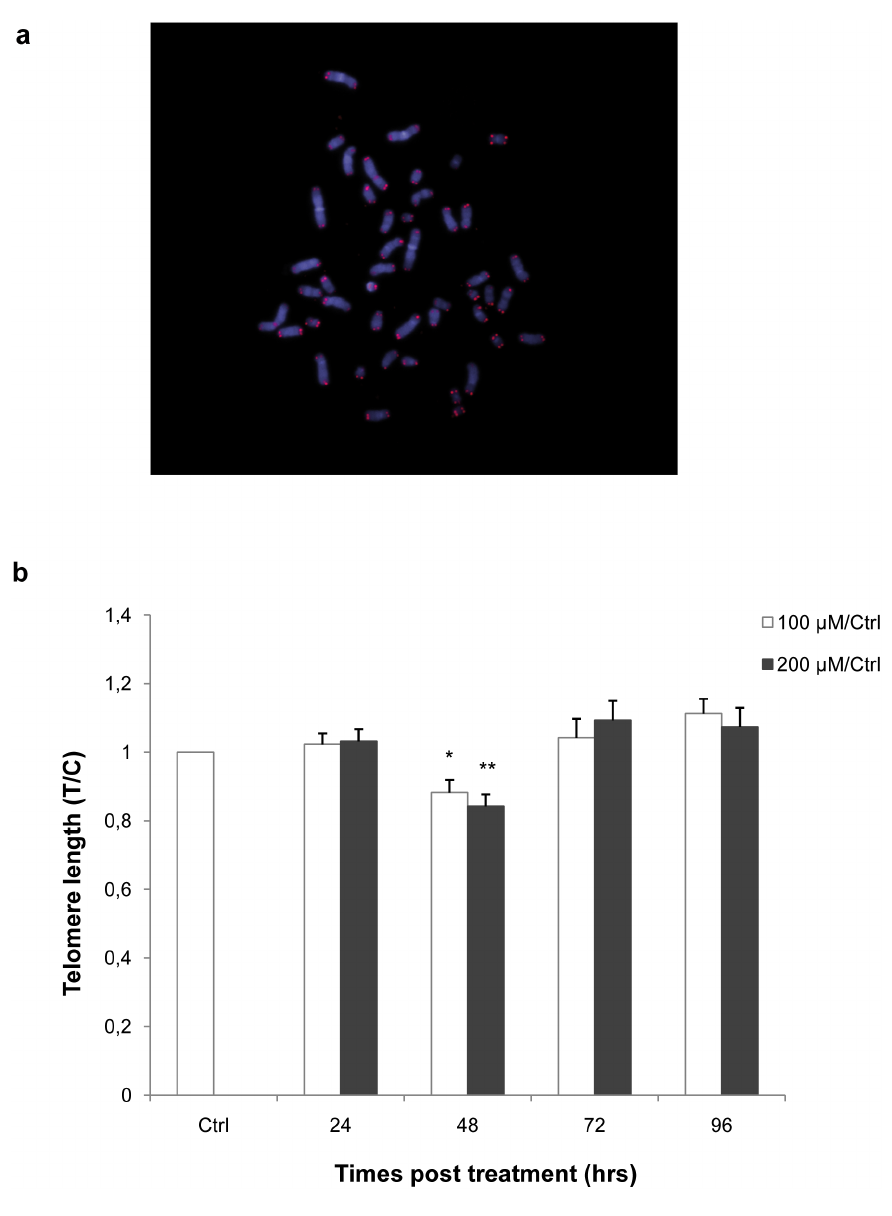
Figure 3. Quantitative-Fluorescence insitu Hybridization analysis. a) Example of cell stained by Q-FISH at metaphase to measure the telomere length. b) The histogram represents results obtained by the analysis of telomere length after hydrogen peroxide treatment. Telomere lengths (T/C) were calculated as the ratio between the total telomeres fluorescence (T) and the fluorescence of the centromere of the two chromosomes 2 (C), used as the internal reference in each metaphase analysed; data obtained from treated samples were normalised to the average ratios measured on the control sample at the same times post treatment. The values less than 1 (control value) represent a significant (100 m M, p , 0.05; 200 m M, p , 0.01) reduction of the telomere length 48 hrs after treatment. Conversely, values at other times were no different than the control. Error bars were calculated using standard error propagation rules. Statistical analysis was performed between treated and control samples. *p , 0.05; **p , 0.01 by Mann-Whitney U